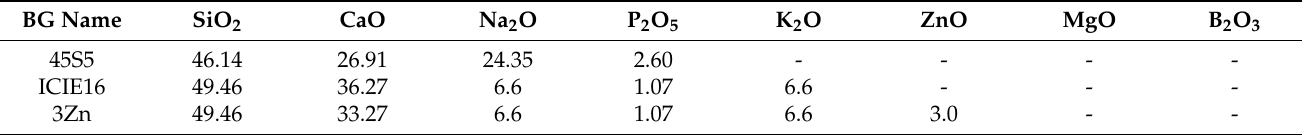
Table 1. Chemical composition of BGs used in this study in